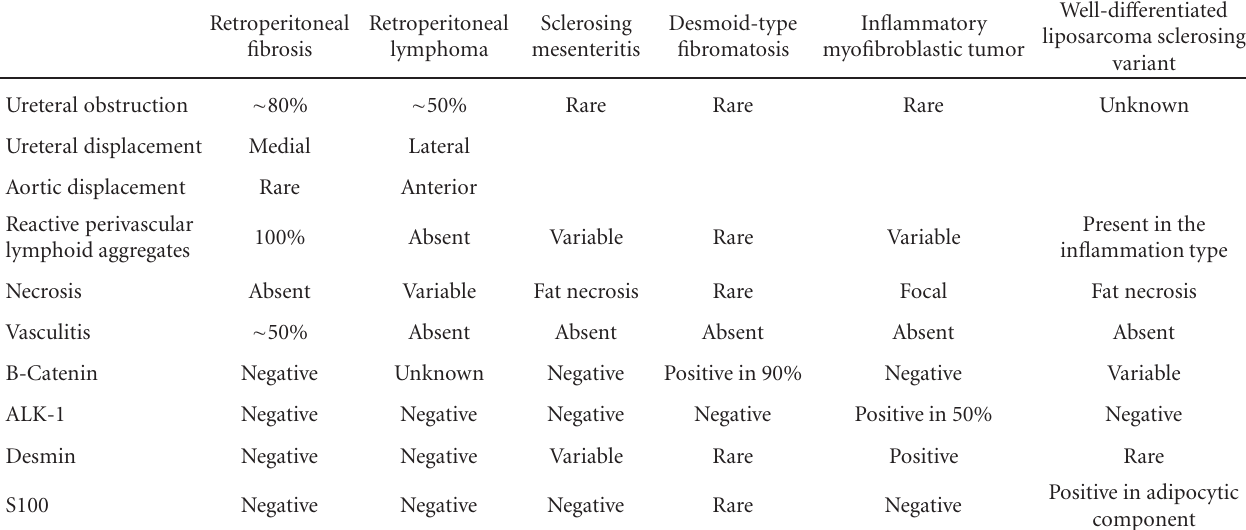
Table 3: Di ff erential diagnosis of retroperitoneal fibrosis